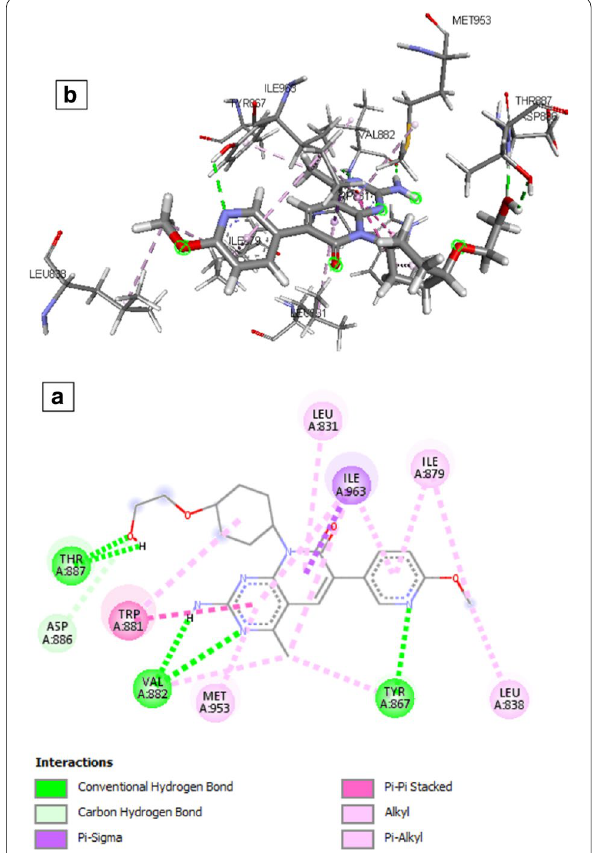
Fig. 5 3D and 2D binding pose interaction of PF-04691502- mTOR kinase complex in b and a respectively. 2D 2dimension, 3D